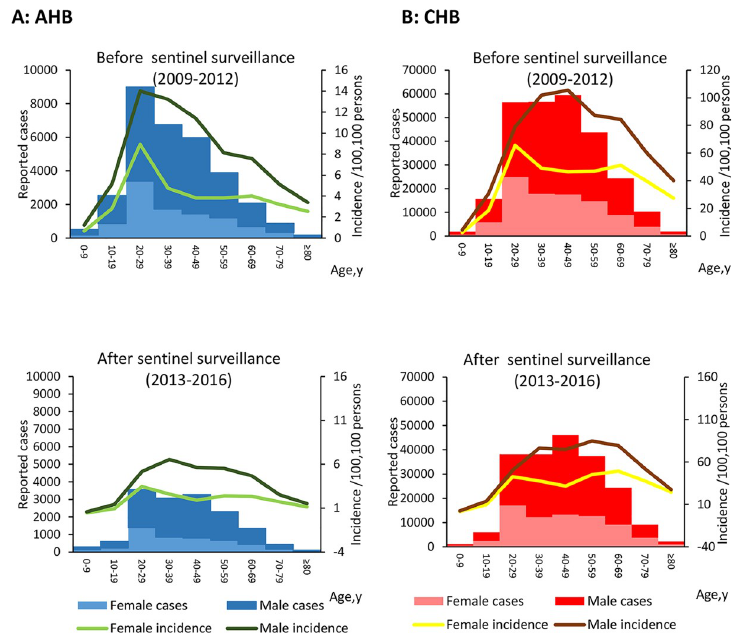
Fig 5. Age-specific and gender-specific cases and incidence of hepatitis B (acute and chronic), China, before and after sentinel surveillance. Age-specific and gender-specific cases and incidence of acute hepatitis B, China, before and after sentinel surveillance. (B) Age-specific and gender-specific cases and incidence of chronic hepatitis B, China, before and after sentinel surveillance. Incidence rates were analyzed by time period (before and after enhancement of surveillance) and age